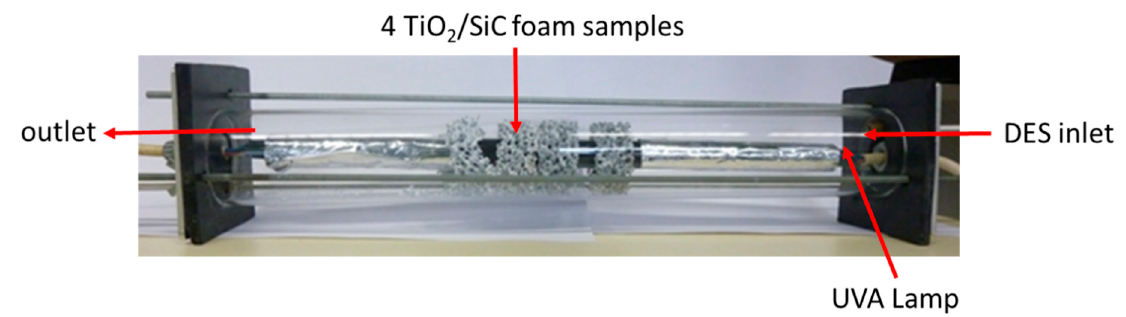
Figure 13. Photocatalytic reactor with TiO 2 -based photocatalysts immobilized on β -SiC foams. One or four foam samples are inserted into the reactor, which represents a bed thick- ness to be crossed of 2 and 8 cm, respectively. Since the length of the lamp (28.8 cm) is larger than the length of the foam bed studied, part of the lamp is masked with aluminum foil to consider only the radial illumination of the lamp. The UV-A lamp is a Sylvania F8W/BLB-T5 lamp with a total irradiance of 79.6 W/m 2 , with a spectral peak centered around 365 nm. DES (Aldrich, 98%) and water were fed at ambient temperature and atmospheric pressure by bubbling air through two saturators, respectively, and mixed with additional air to obtain the required DES-water-air ratio with a constant total air flow. The dry air flow rate is 71 mL/min, 50 mL/min for humid air and 1.5 mL/min for air saturated with DES. The total flow rate is 122.5 mL/min with a DES concentration of 1200 to 1500 ppmv (i.e., 4–5 g/m 3 ) which remains close to the test conditions for